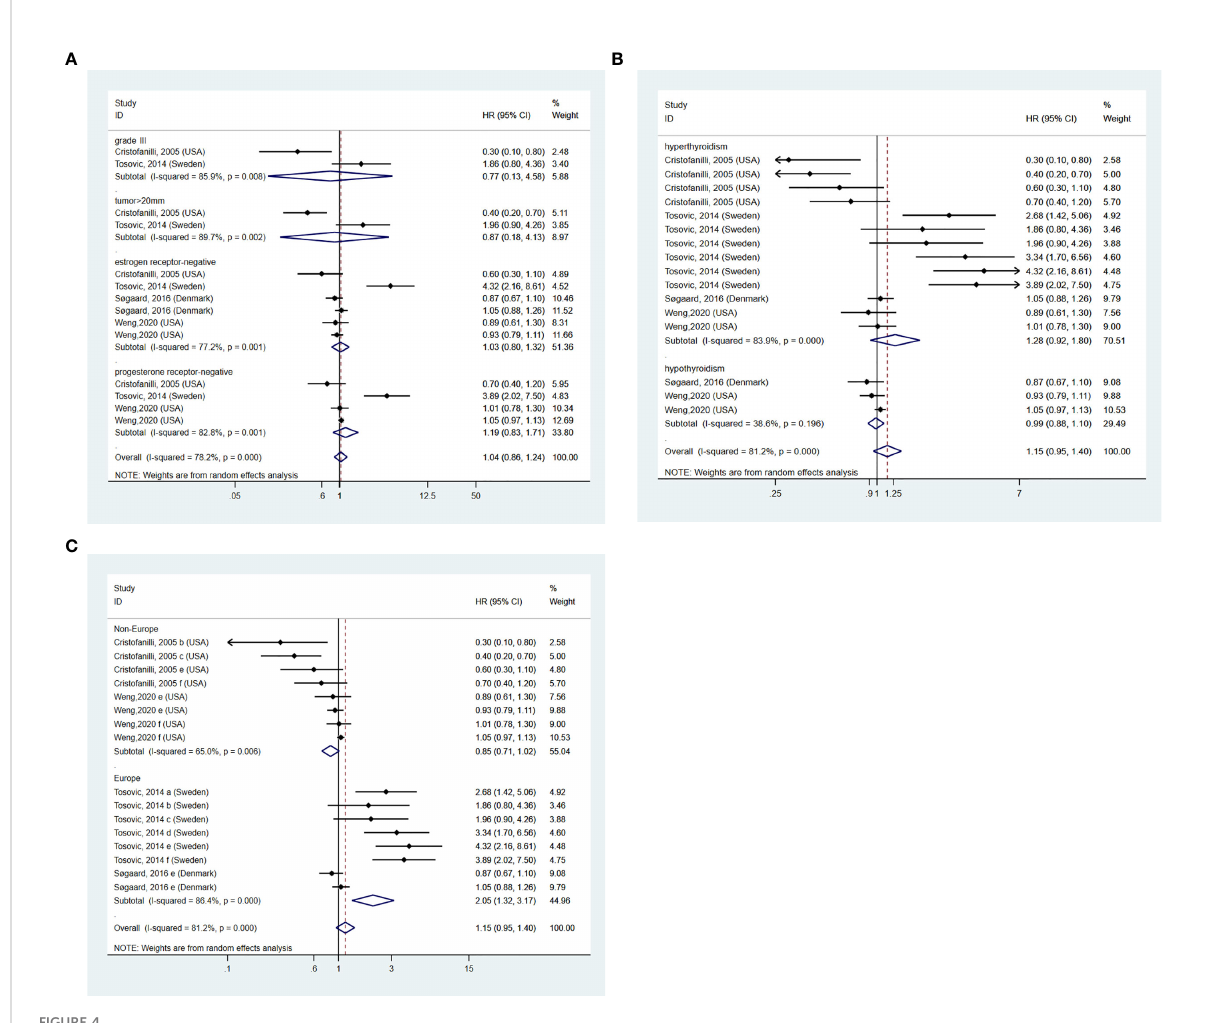
FIGURE 4 (A) BTD and aggressiveness of breast cancer. (B) subgroup analysis of different kinds of BTD on and aggressiveness of BC. (C) subgroup analysis of different regions on the aggressiveness of BC. a=grade II, b=grade III, c=tumor>20mm, d=lymph gland metastases, e=estrogen receptor negative, f=progesterone receptor